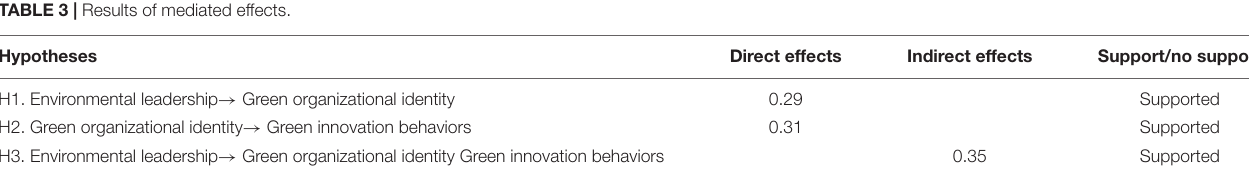
TABLE 3 | Results of mediated